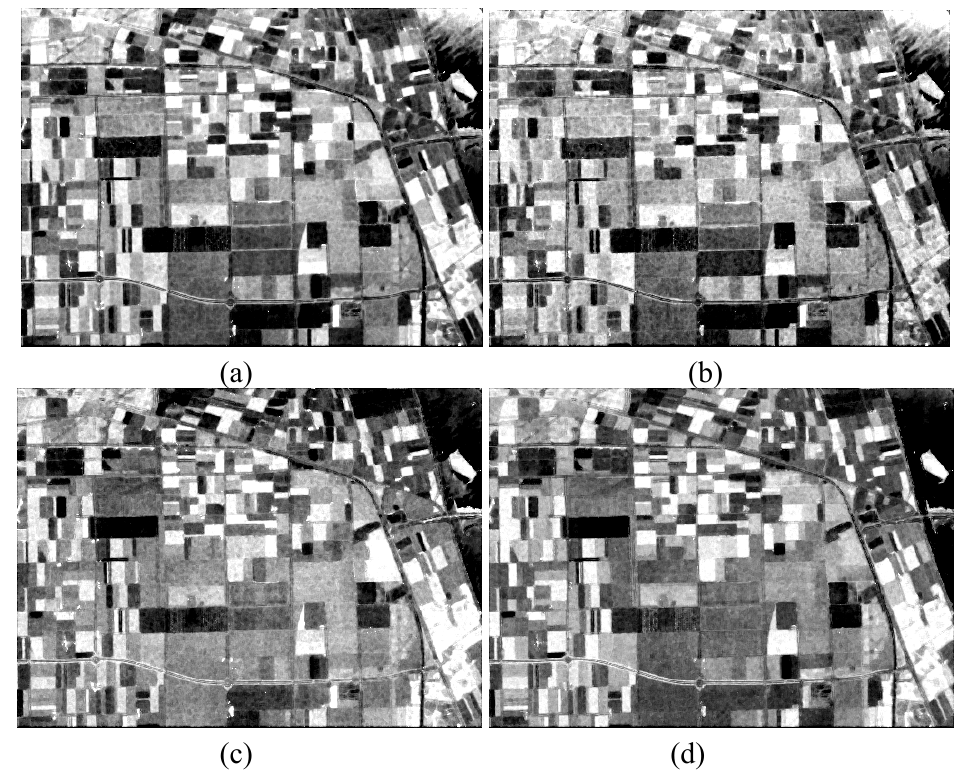
Figure 8. Basic span image and three channels image. ( a ) Span (dB); ( b ) T ( c ) T (dB); ( d ) T 22 33